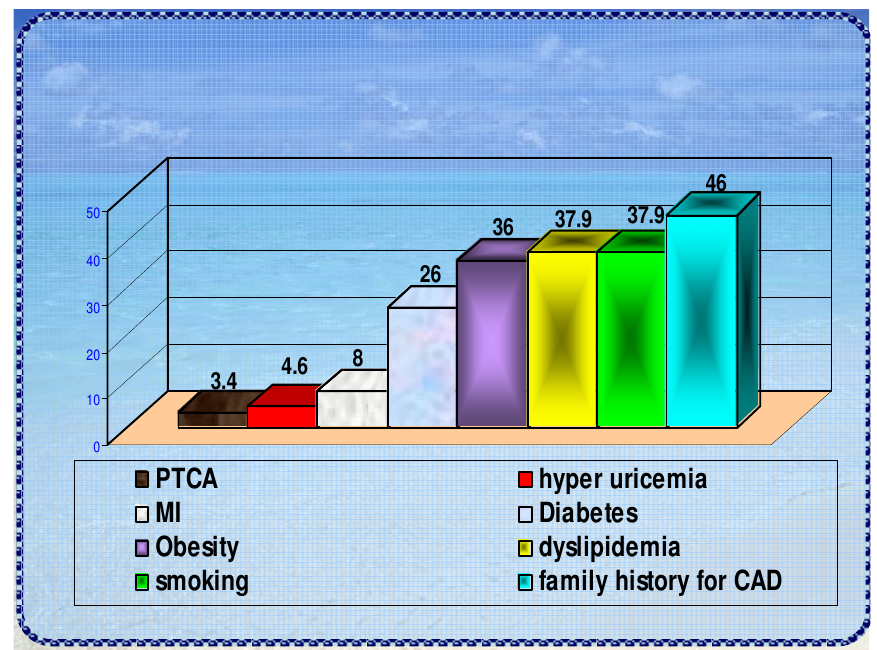
FIGURE 6. The percentage of the most currently associated risk factors among hypertensive Egyptians who presented with chest pain for evaluation in Alpha Center, Cairo, ARE. (From Elkilany, G.E.N. [2005] Myocardial perfusion imaging of high risk hypertensive population in Egypt. Egypt. J. Hypertens. Cardiovasc. Risk 1(2), 32–38. Presentation during the World Hypertension League 2005